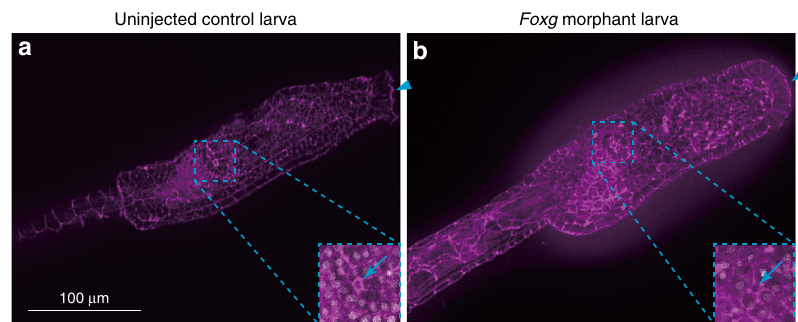
Fig. 5 Knockdown of Foxg does not affect the atrial siphon primordia. Z-projected images of the trunk region of a a control larva and b a larva developed from an egg injected with the Foxg MO, which were stained with phalloidin. Arrowheads indicates the anterior tip. Note that the palps were lost in the Foxg morphant larva. Atrial siphon primordia in the right side are shown in higher magni fi cation views. The openings are indicated by arrows. In higher magni fi cation views, nuclei are stained by DAPI are shown in gray